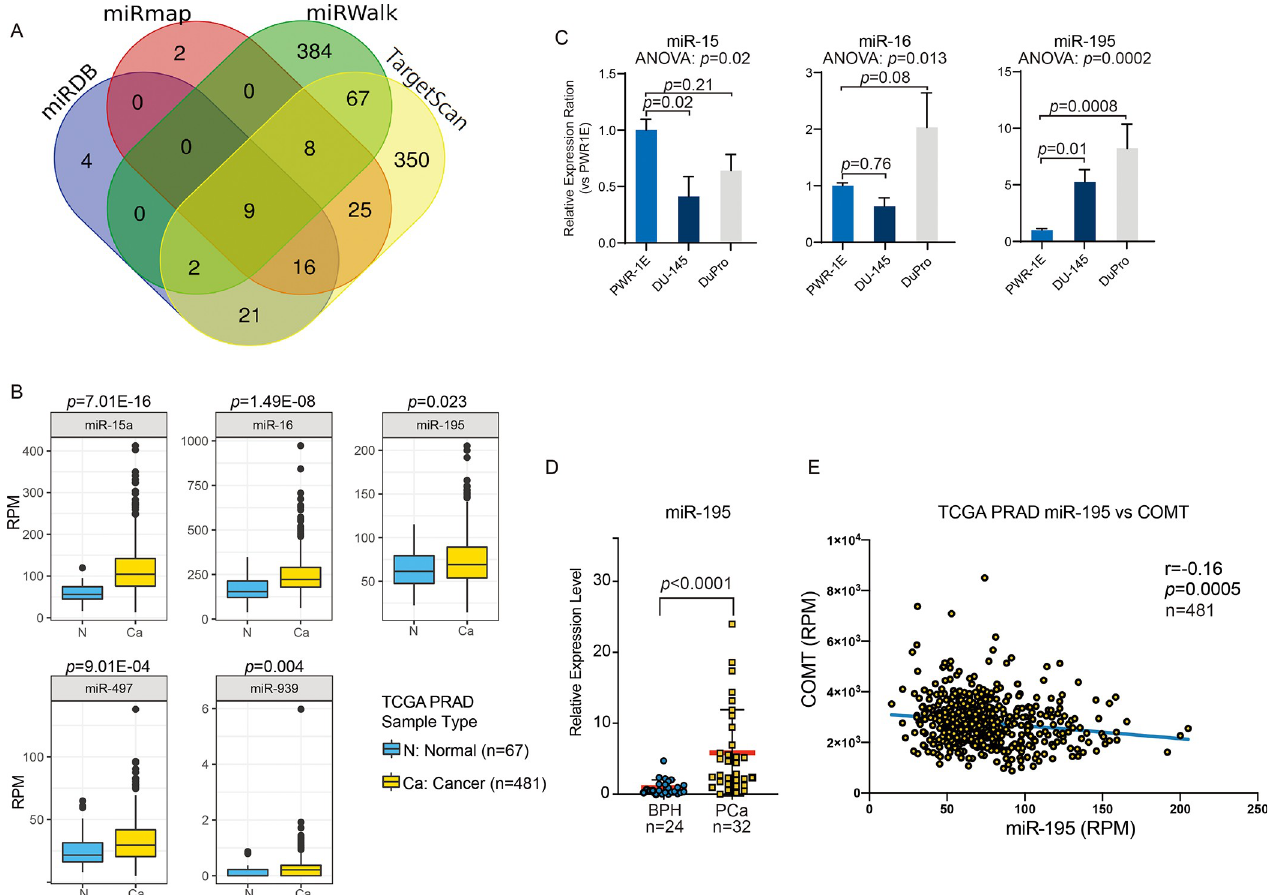
Fig 5. Associations between COMT and miRNA. (A) Venn diagram consisting of four databases (miRDB, miRmap, miRWalk, TargetScan) indicating 9 possible miRNAs capable of binding COMT gene. (B) Of candidate miRNAs identified by all four databases to bind COMT, five showed oncogenic effect according to TCGA. (C) Of these five, miR-195 is the only miRNA determined to be upregulated in both parental DuPro and DU145 compared to PWR-1E cells. MiR-497 and miR-939 were not analyzed due to low RPM ( < 50) in TCGA. The p -values are based on Dunnett’s multiple comparison test (shown for each comparison) following one-way ANOVA test ( p -value shown below graph title). (D) miR-195 was also upregulated in clinical specimens of prostate cancer (n = 32) compared to BPH (n = 24) as determined by real-time PCR. (E) Spearman nonparametric correlation analysis between COMT versus miR-195 expression in TCGA. The slope shows simple linear regression Data are presented as mean ± SD. The p -values are based on Mann-Whitney U-test in B and